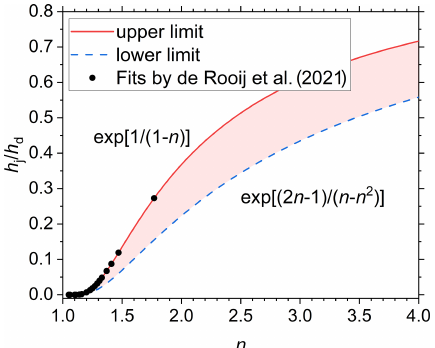
Figure 3. The limits imposed on the matric potential at the junction point h j (scaled by the matric potential at oven dryness h d ) by the requirement that shape factor α be positive (upper limit) and by the minimum value of α for any specific value of n (lower limit). The shading indicates the area with plausible parameter combinations. The dots represent de Rooij et al.’s (2021) fits of Eq. (1) with α instead of h d as a fitting parameter for 21